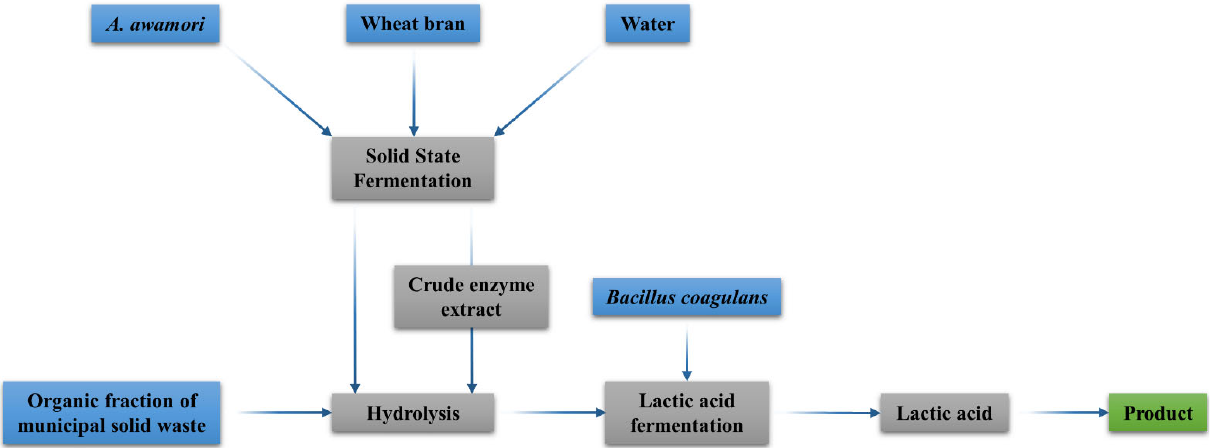
. Figure 1. Novel bioprocess for producing enzymes from wheat bran to obtain lactic acid from the organic fraction of municipal solid waste.